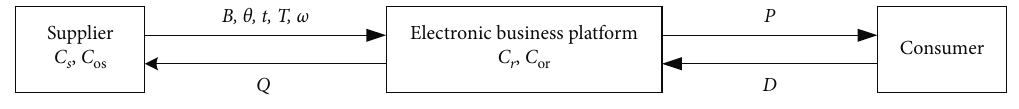
Figure 5: Fresh food e-commerce supply decision flow